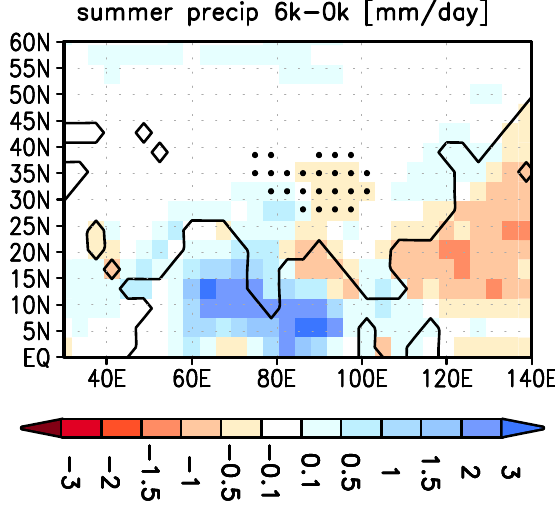
Fig. 13. Summertime precipitation changes [mm/day], which are attributed to the ocean-atmosphere